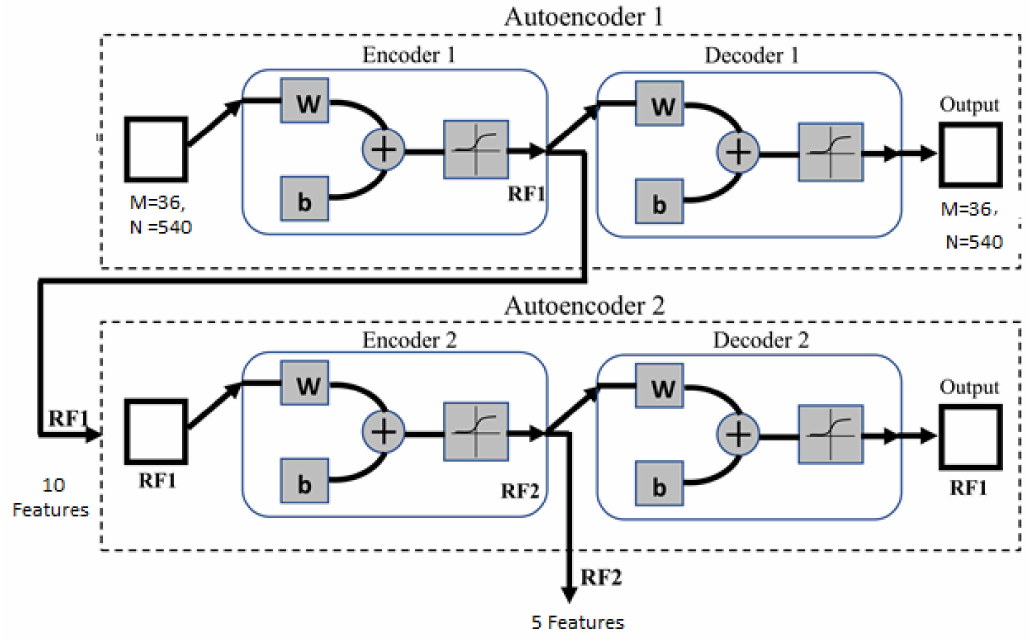
Figure 6. Two- Stages stacked deep autoencoder for Selecting Key features for Forecasting the oil, and gold